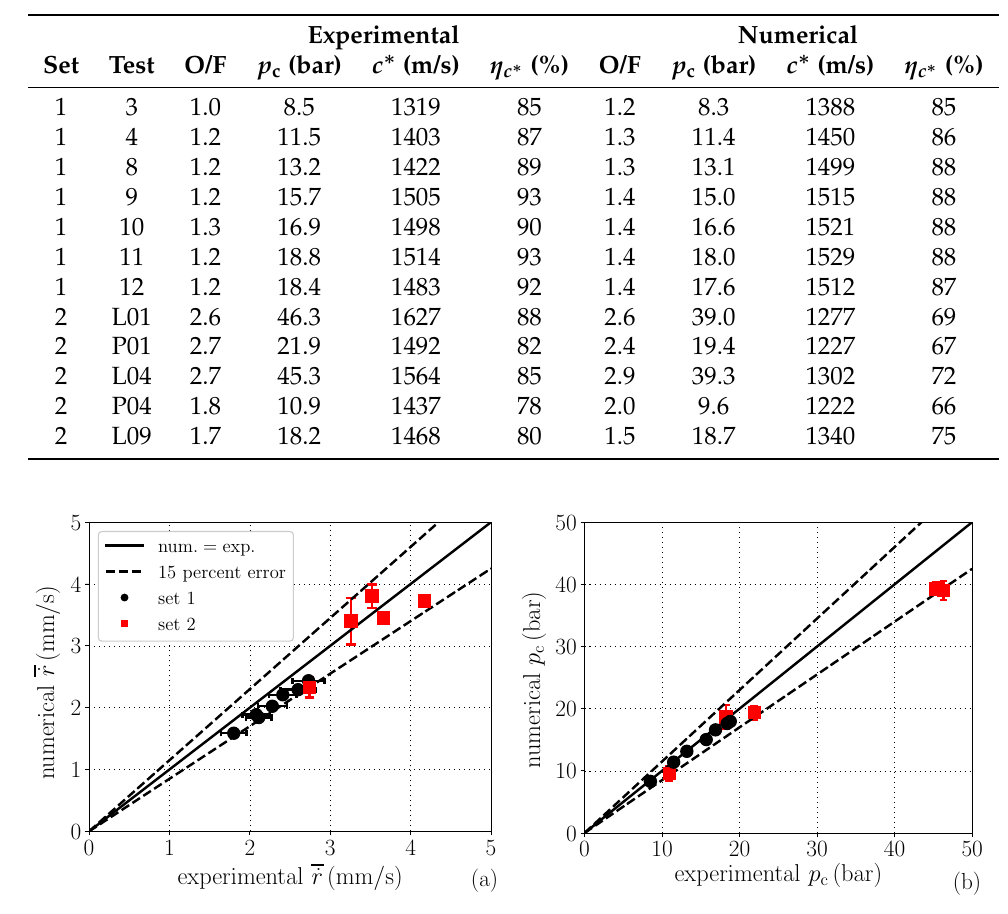
Table 4. Experimental and numerical oxidizer-to-fuel ratio, chamber pressure, characteristic velocity, and combustion efficiency for all tests in Table 2.